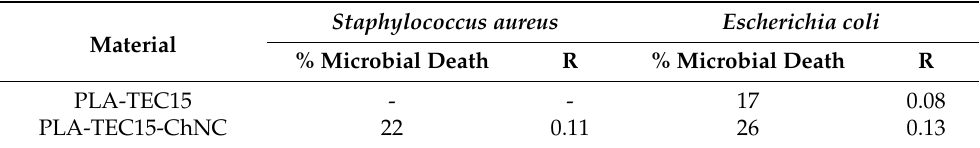
Table 5. Antibacterial properties of PLA-TEC15-ChNC film showing an antibacterial activity against common